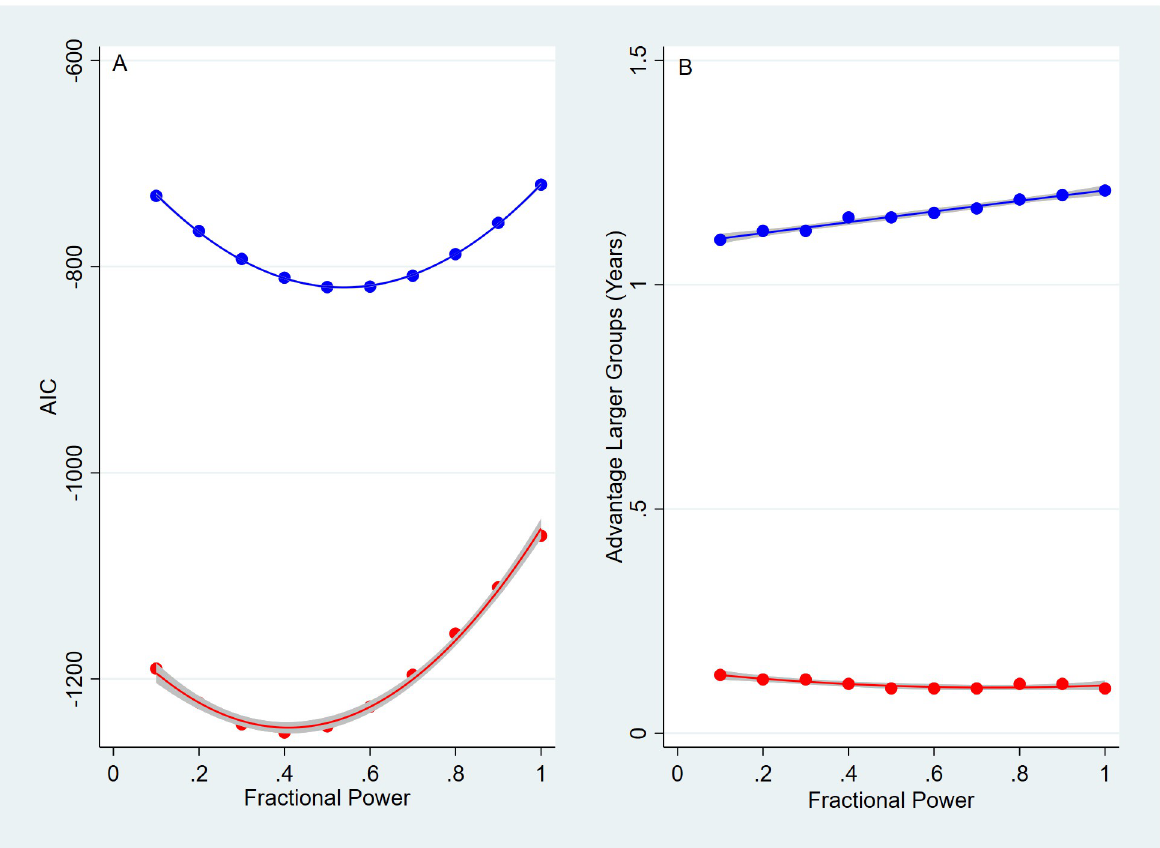
Fig 4. AIC values and advantage large research group vs. fractional power. Parametric survival analysis with a log-logistic distribution and gamma frailty used the small model (the four highly significant variables and interaction term shown in S4 Table in S1 File) with number and rate of publication divided by the fractional powers (k) of the number of authors, or N k , with k varying from 0.1 to 1 in steps of 0.1. Remember a fractional power of zero is the same as dividing by one which is the average value. On the left, see A, the AIC values associated with each fractional power are plotted. The minimum AIC value occurs at a fractional power of about 0.41 for associate professors and about 0.54 for full professors. On the right, see B, is the average advantage in years of being a member of a larger vs. small research group as estimated with survival analysis. The average of the number of authors per publication was used to create larger and smaller research groups used 2.85 for associate professors and 3.38 for full professors. Associate professors are shown in red, full professors in blue, the fitted line is a quadratic in A and for associate professors in B with a linear fit for full professors in B. The 95% confidence intervals are